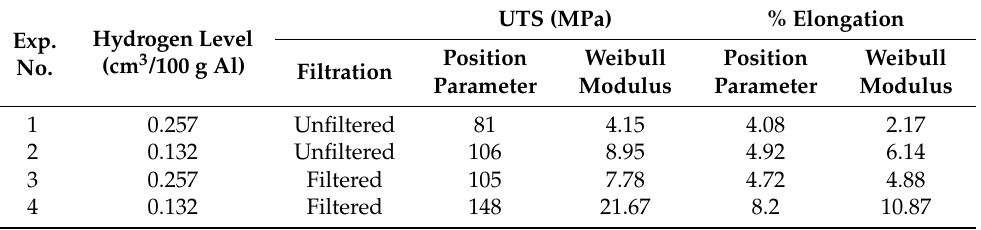
Table 2. Position parameter and Weibull modulus of cast specimens produced under different